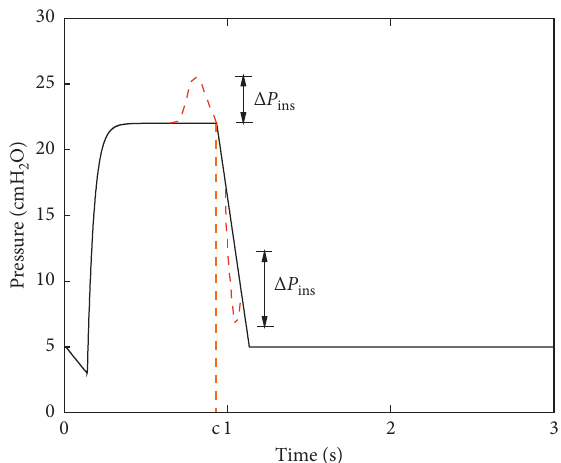
, the trigger time; b: t trigger , the time to reach effective ventilation level (95% of the P effective